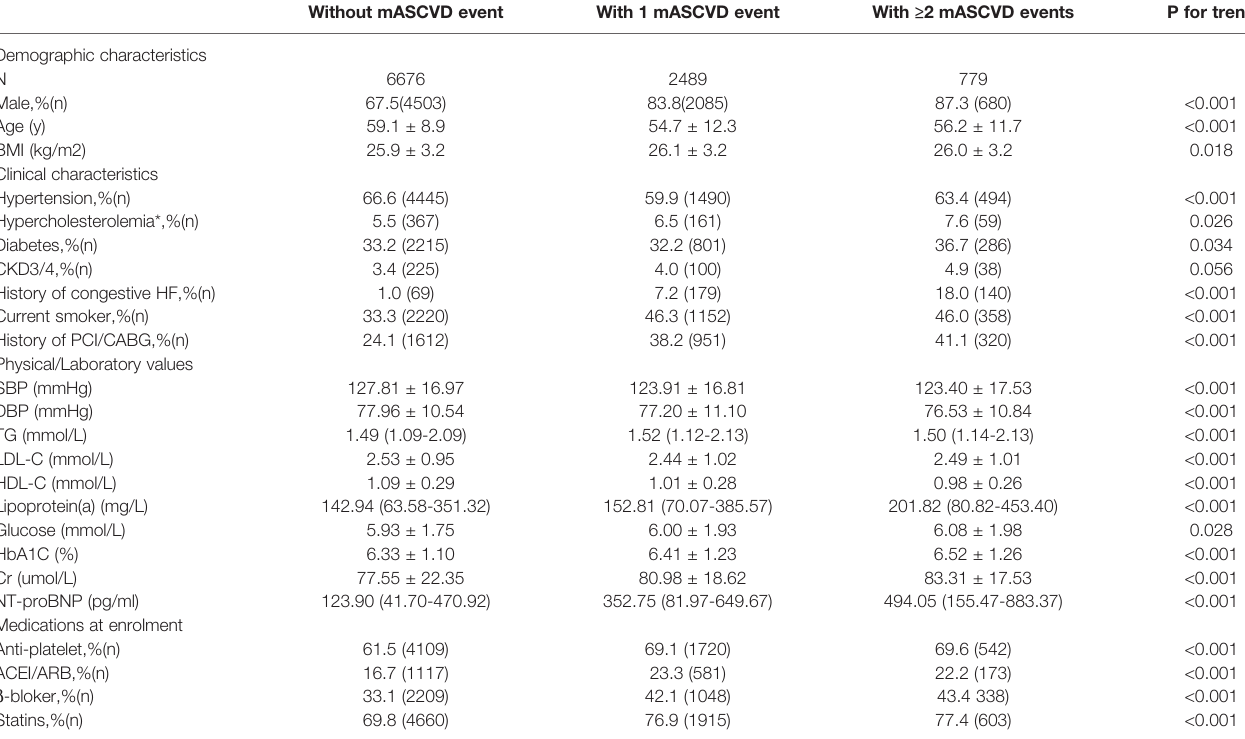
TABLE 1 | Baseline characteristics by ASCVD categories. Without mASCVD event With 1 mASCVD